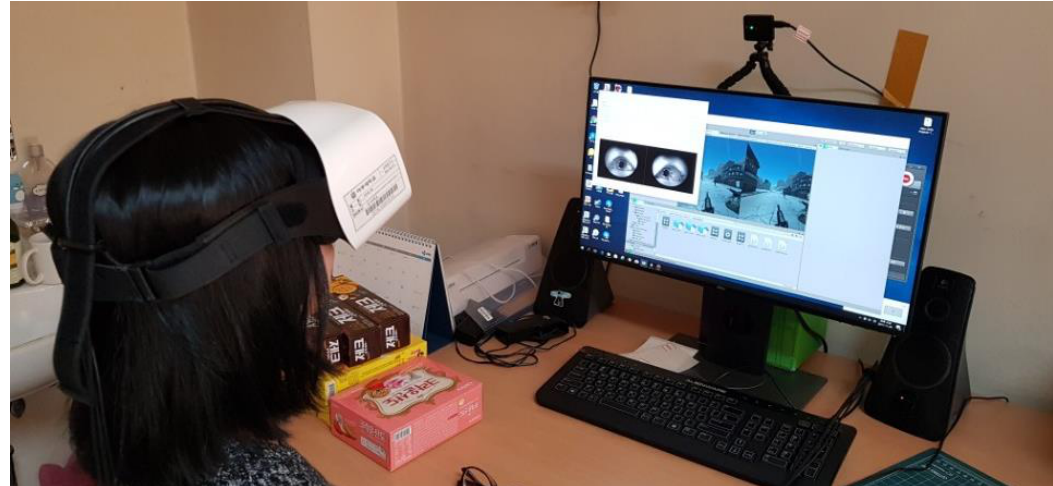
Figure 5. A snapshot of the experimental setup—a moment that calibrates the FOVE head-mounted display (HMD).